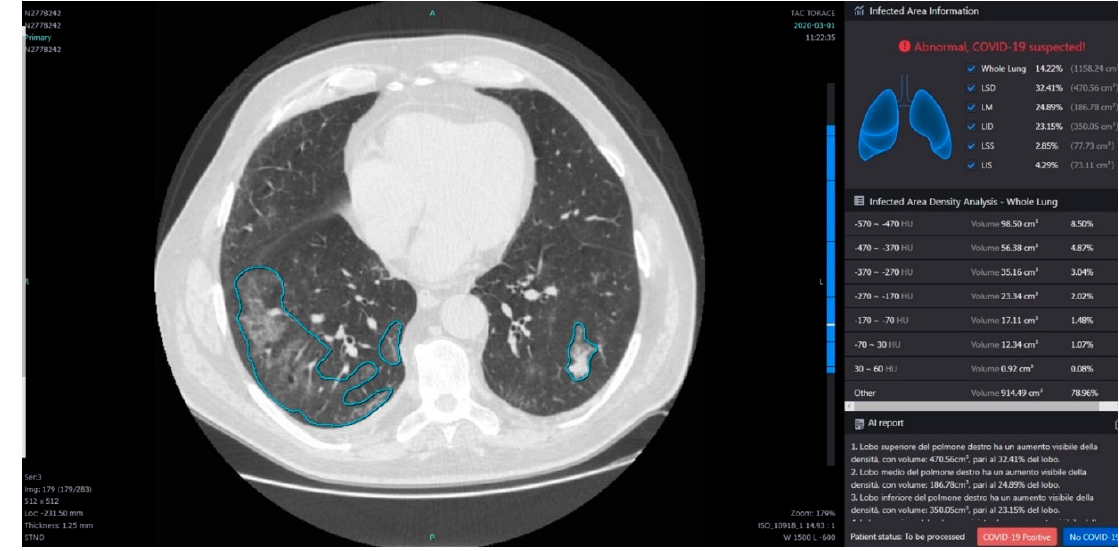
Figure3. ThesamecaseofFigure1. AutomaticSegmentation(Blueshapedinfectedareadensityanalysis) Figure 3. The same case of Figure 1. Automatic Segmentation (Blue shaped infected area density of Thoracic Disease by COVID-19 using the InferRead Tool of analysis) of Thoracic Disease by COVID-19 using the InferRead Tool of InferVision.